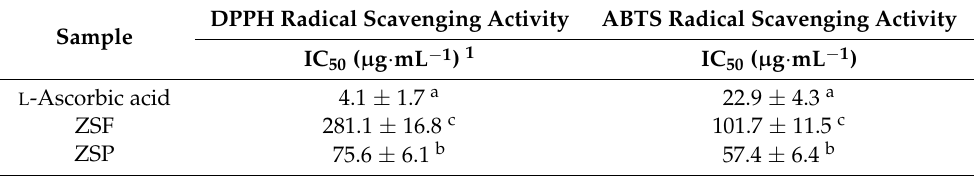
Table 5. 2,2-Diphenyl-1-picrylhydrazyl (DPPH) and 2,2 (cid:48) -azino-bis-3-ethylbenzothiazoline-6-sulfonic acid (ABTS) radical scavenging activity of Zanthoxylum schinifolium